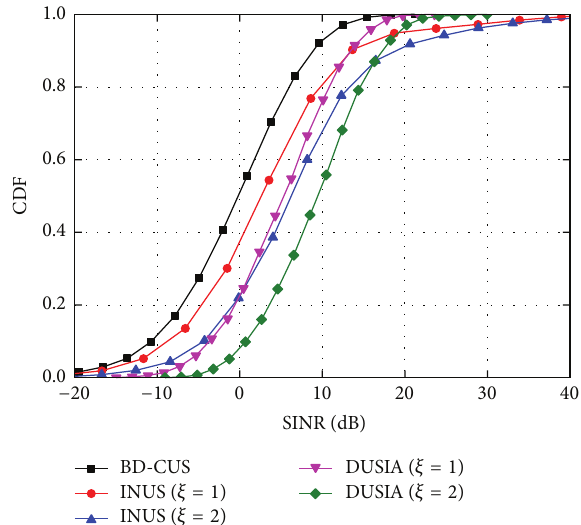
Figure 2: CDF of users’ achievable SINR comparison with 𝑁 = 4 and 10 users per